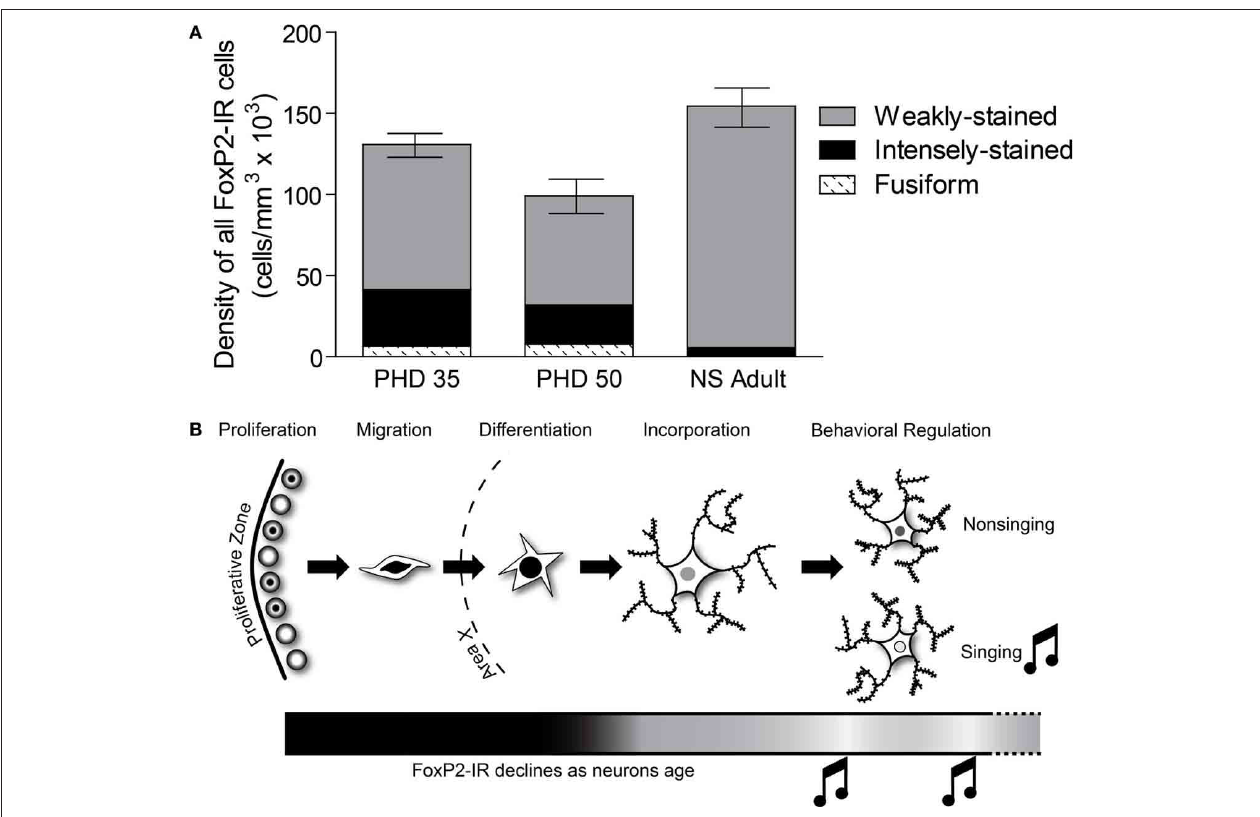
FIGURE 9 | The relative distribution of the different categories of FoxP2-IR in Area X changes across development. (A) In PHD 35 and 50 males, nearly one-third of all FoxP-IR cells were either intensely-stained or fusiform-shaped, whereas these categories made up less than 5% of the cells